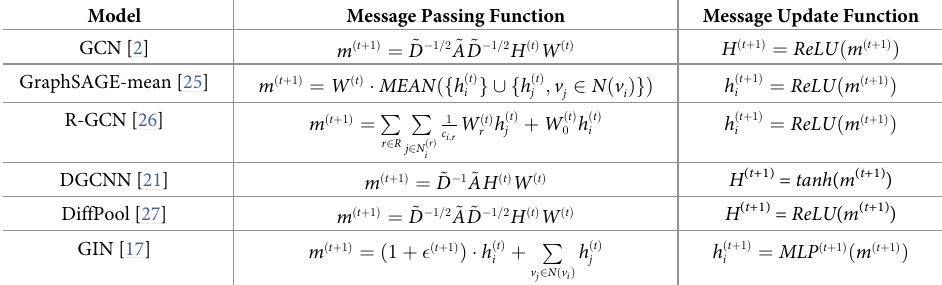
Table 1. Different graph neural network models based on MPNN framework. Model Message Passing